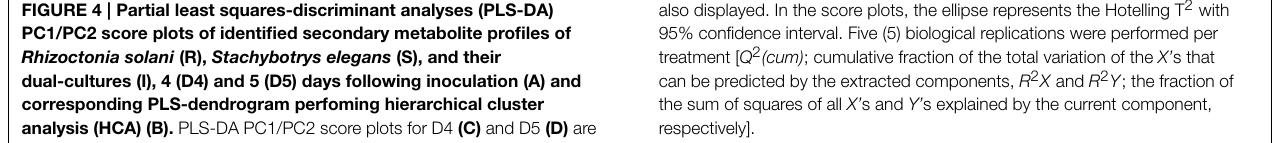
also displayed. In the score plots, the ellipse represents the Hotelling T 2 with 95% confidence interval. Five (5) biological replications were performed per treatment [ Q 2 (cum) ; cumulative fraction of the total variation of the X’ s that can be predicted by the extracted components, R 2 X and R 2 Y ; the fraction of the sum of squares of all X’ s and Y’ s explained by the current component,